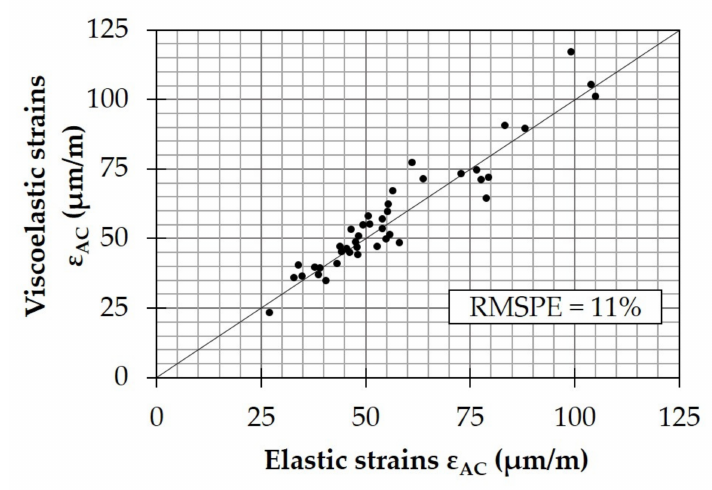
Figure 11. Comparison of horizontal strains at the bottom of the AC.